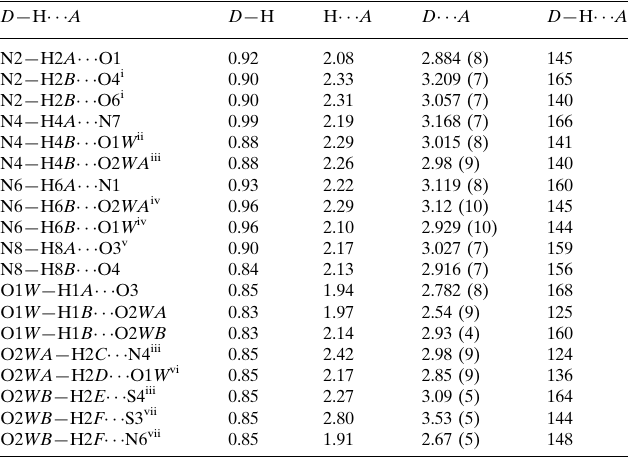
Hydrogen-bond geometry (A˚ , (cid:3)